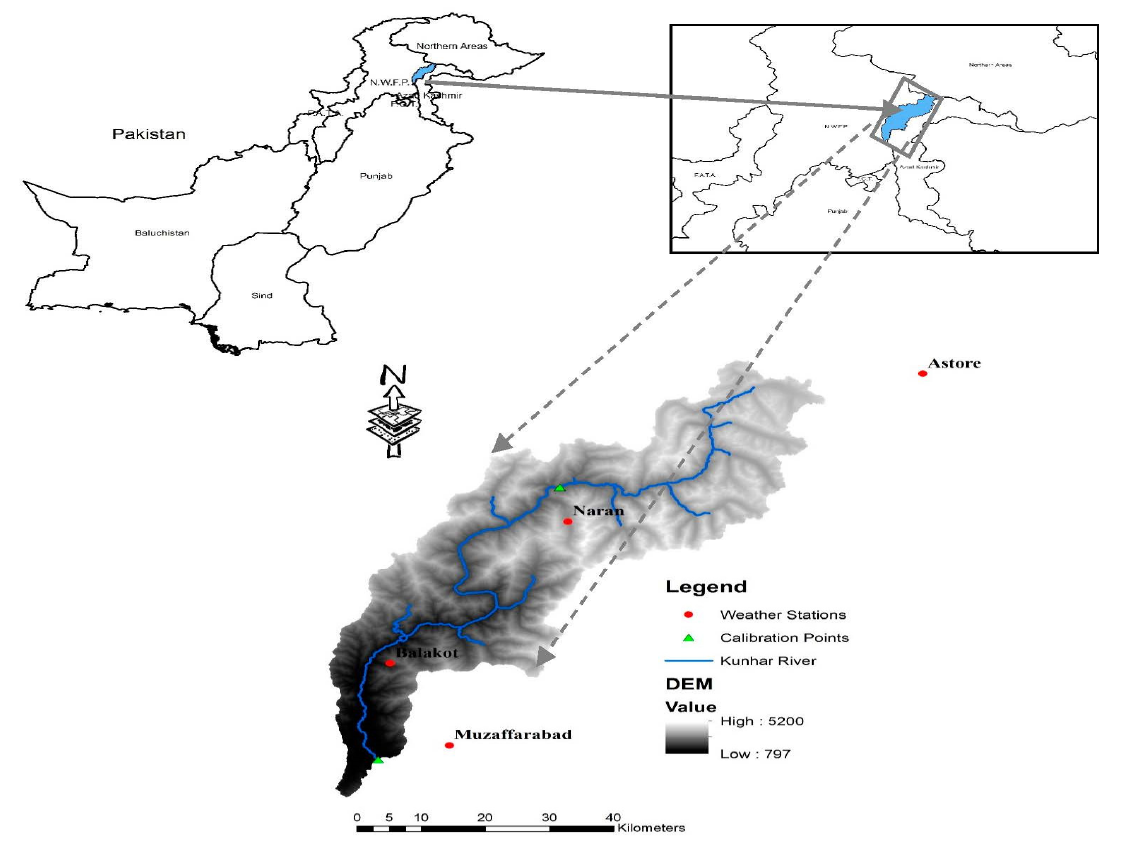
Figure 1. A map of the Kunhar River Basin.